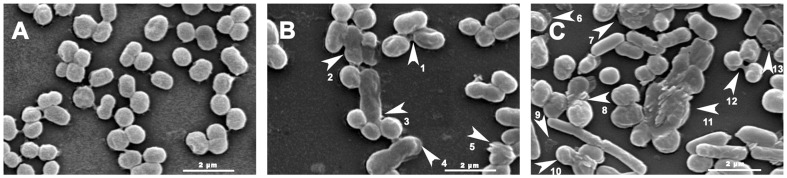
Scanning electron micrographs (SEM) of C. michiganense subsp. sepedonicum cells.Untreated (A, 10000×); treated with Fractionation three at the MIC concentration (B, 10000×), and treated at 2MIC concentration (C, 10000×). Extracellular leakage of cell content (1, 6, 12, 13), cells gathered into “clumps”(2, 7, 8, 11, 12), misshapen cells (3), blebs of damaged cells (4), roughened cell surfaces (5), collapsed surfaces (7, 8, 10, 11, 12), fragmentation (9), swollen cells (7, 8, 10, 12), disrupted cytoplasmic membrane (8, 10, 11, 12), and cell lysis (9). MIC, Minimum inhibitory concentration.